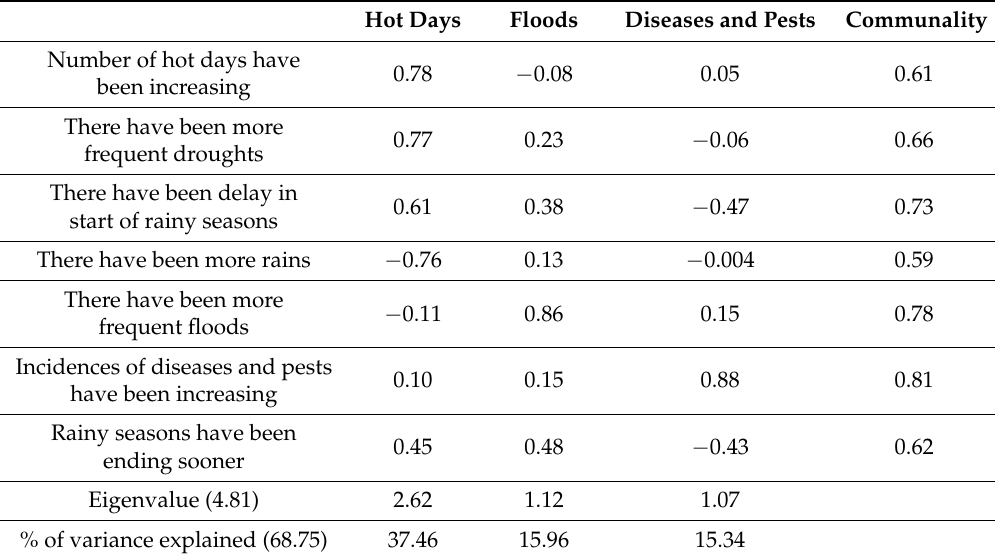
Table 3. Factor loadings and communalities for climate change perceptions of farmers in the Eastern region ( n = 241). Hot Days Floods Diseases and Pests Communality Number of hot days have 0.78 − 0.08 0.05 0.61 been increasing There have been more 0.77 0.23 − 0.06 0.66 frequent droughts 0.61 0.38 − 0.47